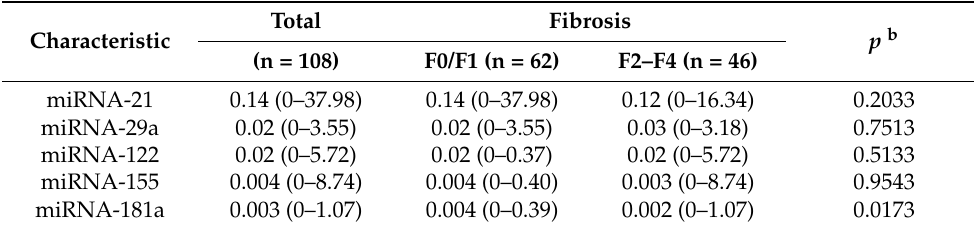
Table 2. Expression of microRNAs according to absence of clinically significant fibrosis (F0–F1) or the presence of clinically significant fibrosis